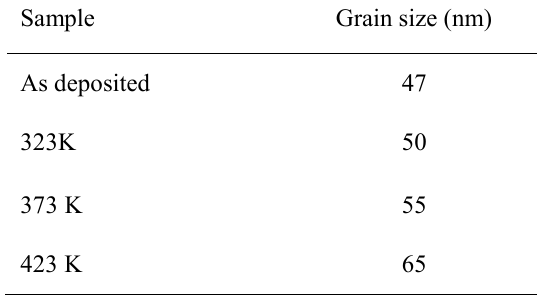
PcOC thin films annealed at different 2 8